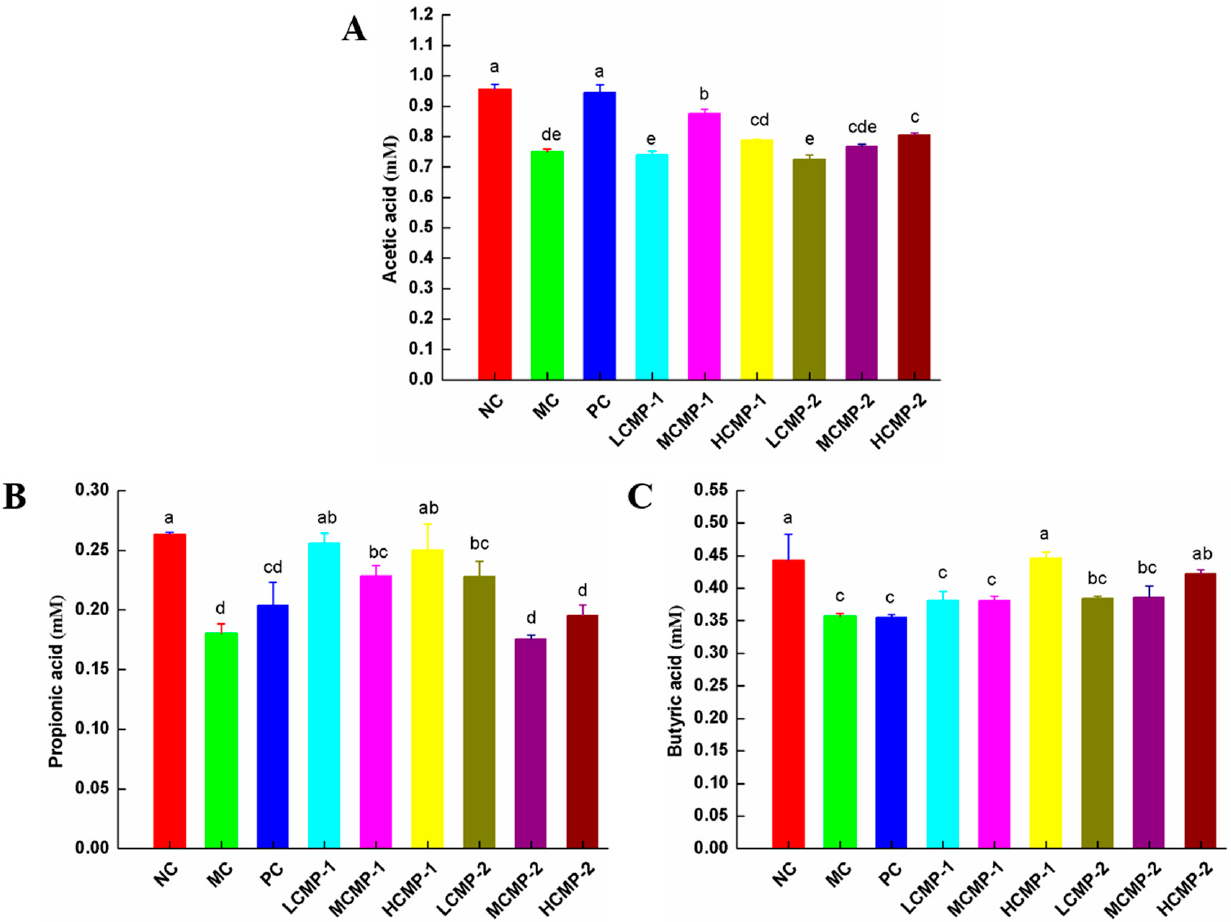
Figure 6. Effects of CMP-1 and CMP-2 on the contents of -acetic acid ( A ), propionic acid ( B ) and butyric acid ( C ) in the cecal contents. The significant differences ( p < 0.05) are marked as various superscript small letters (a–e).